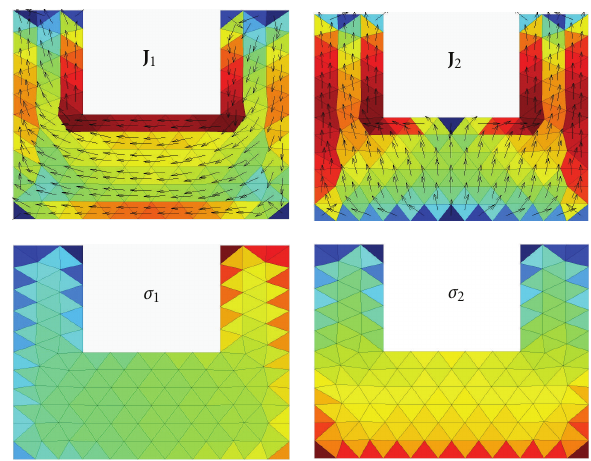
Figure 9: The first two characteristic modes (currents and charges) for the SAU1 structure.